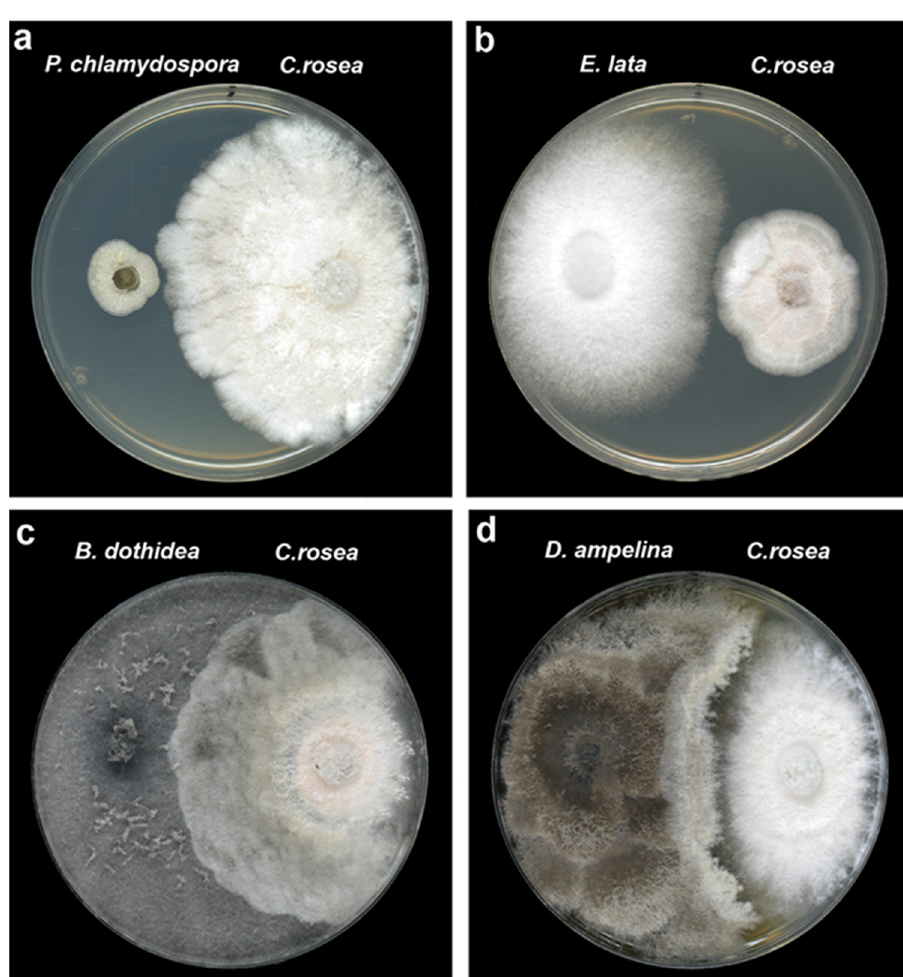
Fig 1. In vitro confrontation tests of C . rosea 19B/1 strain with GTD pathogens growing on potato dextrose agar medium. ( a ) P . chlamydospora , 15 days post inoculation (dpi); ( b ) E . lata , 8 dpi; ( c ) B . dothidea , 15 dpi; ( d ) D . ampelina , 15 dpi.